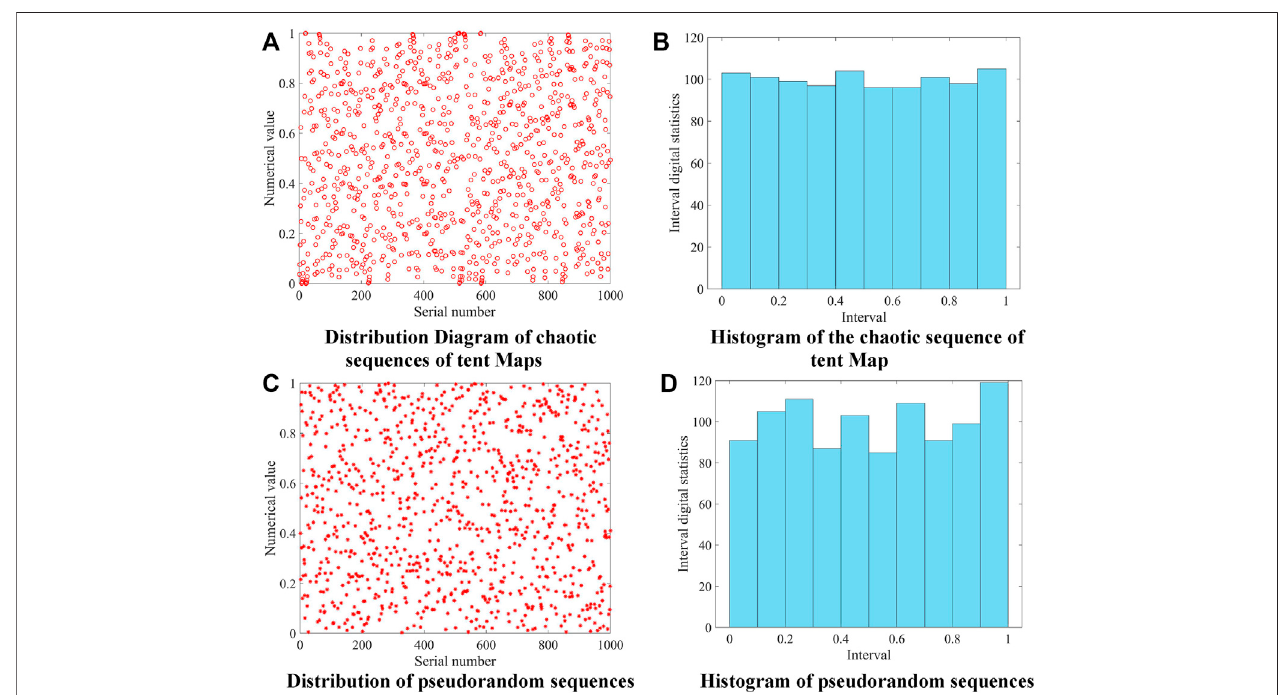
FIGURE 1 | Comparison of two kinds of random number generators.